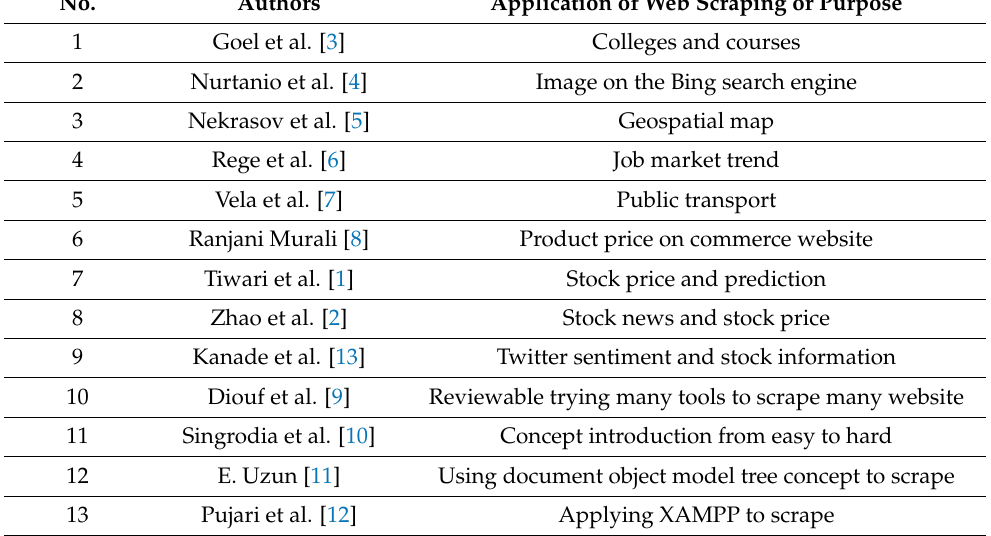
Table 1. Comparative related